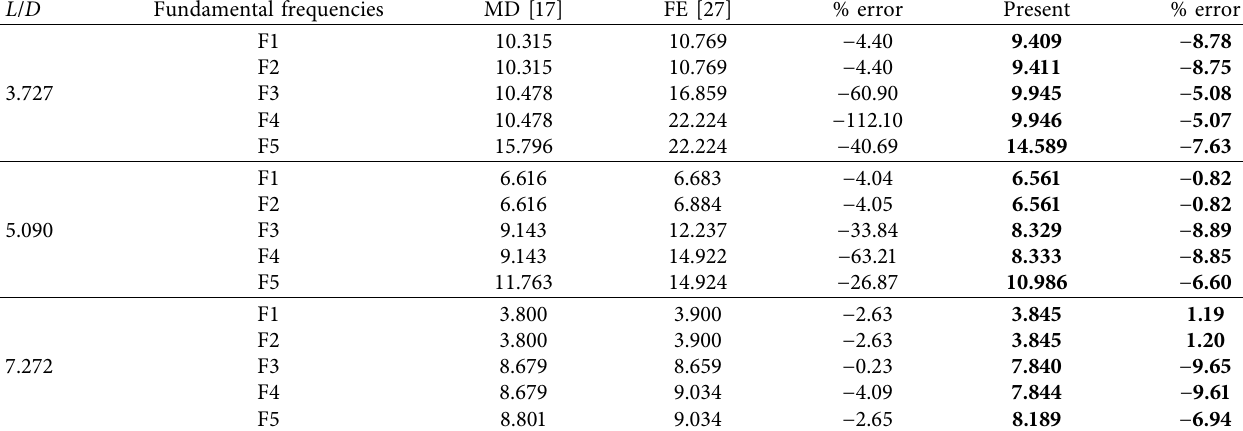
Table 1: Fundamental frequency comparisons for the present FE work with existing MD work. L / D